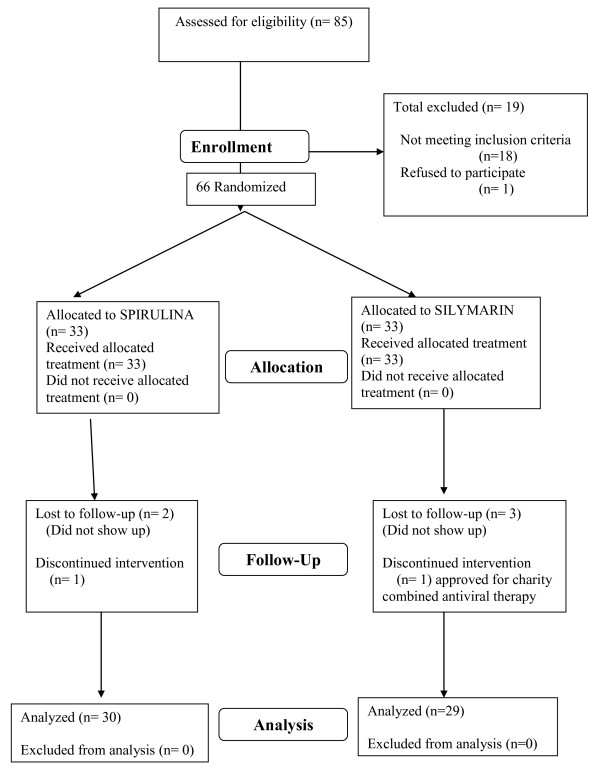
Flowchart of patients.